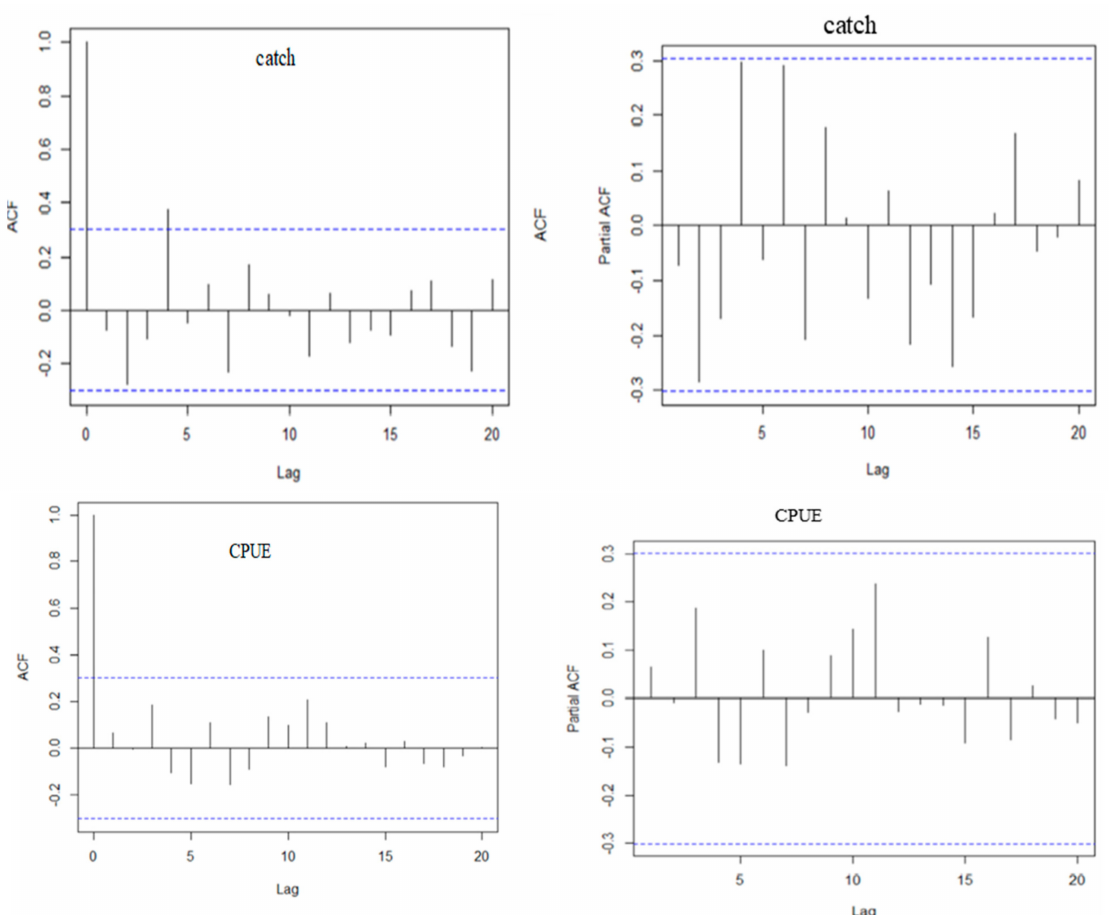
Figure 7. Autocorrelation and partial autocorrelation functions residuals.